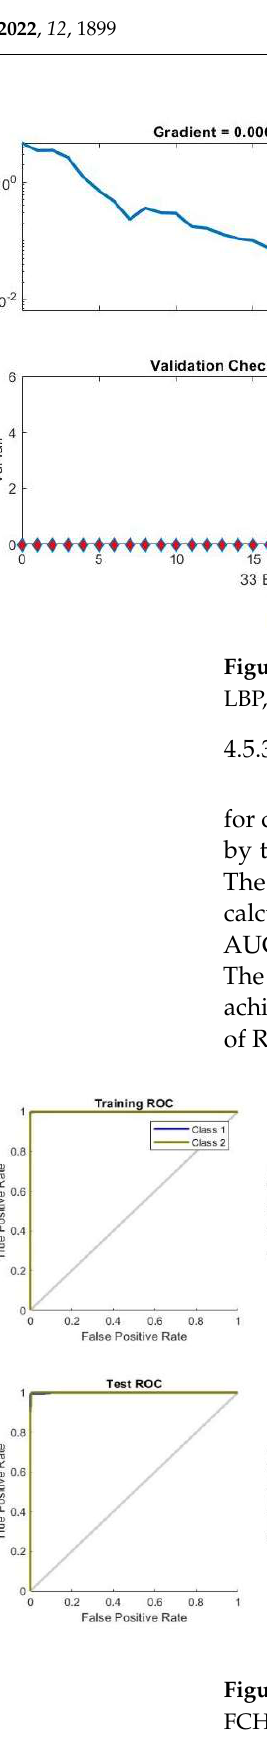
14 of 23 Figure 8. Error histogram for evaluating ANN performance based on hybrid features. ( a ) AlexNet, DWT, LBP, FCH, and GLCM; ( b ) ResNet-18, DWT, LBP, FCH, and GLCM. 4.5.2. Gradient and Validation Checks Gradient and validation checks are one of the ANN’s performance criteria for classi- fying histological images of OSCC. This tool obtains the best network performance through gradient and validation checks in each epoch that records gradient and validation checks so that the best performance is obtained at the minimum error. Figure 9 shows the